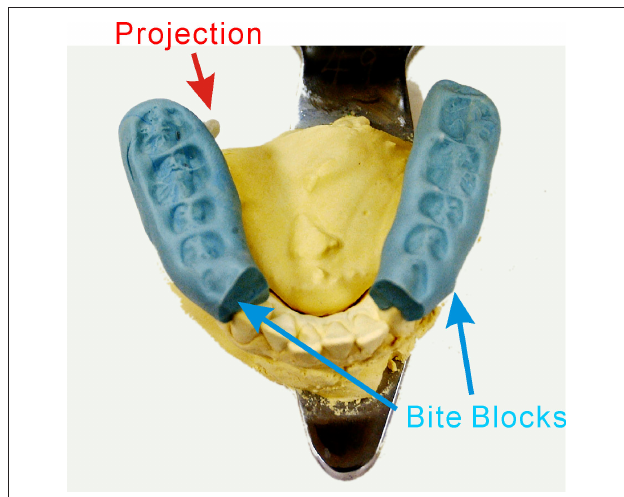
FIGuRE 6 | Schematic drawings of the relationship between tongue movement and a protrusion in each task. Tongue movement itself is the same in the control and all four tasks. Each part of the tongue is stimulated with a protrusion by a protruded movement of the tongue. The shaded areas of the tongue are stimulated by a protrusion. LA, left antero-lateral stimulation; LP, left postero-lateral stimulation; RA, right antero-lateral stimulation; RP, right postero-lateral stimulation. Adopted from Sakamoto et al.